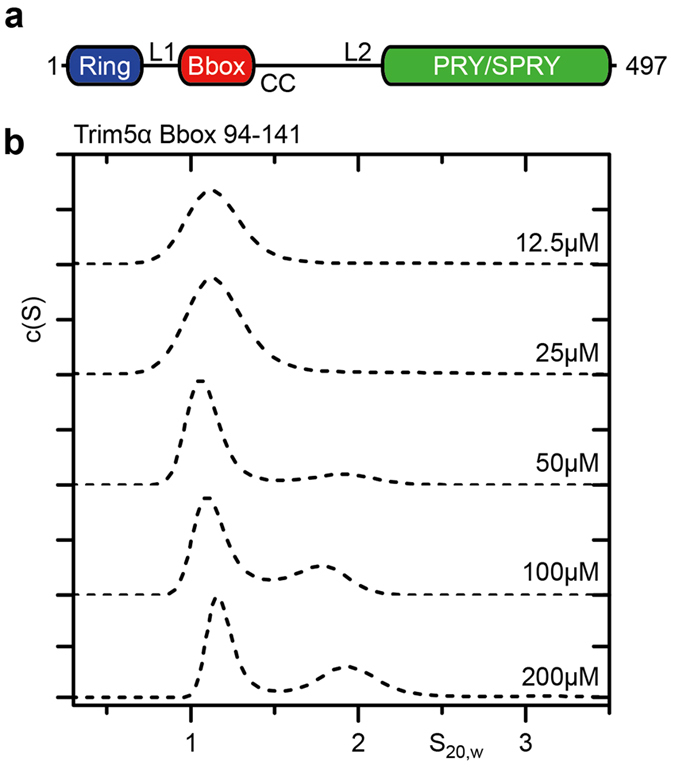
The Trim5α Bbox domain shows weak self-association.(a) Diagram of the Trim5α domain arrangement. (b) Sedimentation velocity c(S) analysis of RhT5α 94–141 over a concentration range of 12.5 μM and 200 μM. Normalised c(S) profiles for each concentration are shown. The emergence of a second peak is evident above 50 μM.